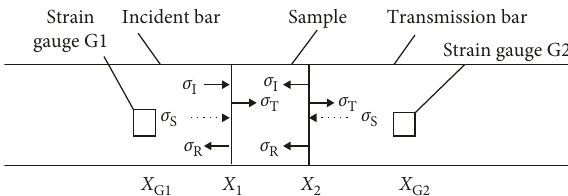
Figure 10: Loading diagram of a specimen under static-dynamic load.